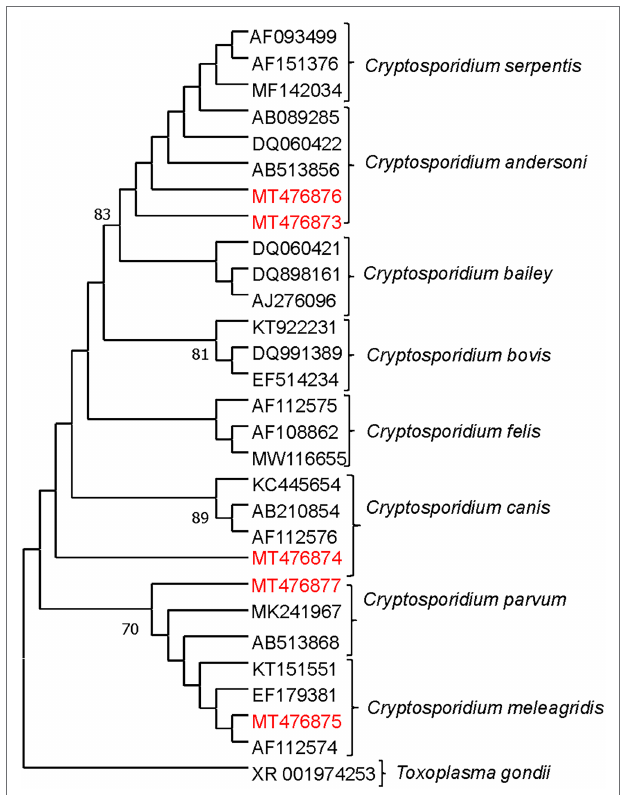
FIGURE 4 | Maximum likelihood phylogenetic analysis of Cryptosporidium detected from river water samples. The analysis was constructed by using Tamura 3 parameter model with MEGA 7.0 and the bootstrap values were calculated with 1,000 replicates. The analysis was based on the SSU gene. The phylogenetic tree was rooted to Toxoplasma gondii . The numbers at branch nodes represent bootstrap values greater than 70. Reference sequences included in the analysis are shown with their respective GenBank accession numbers. Cryptosporidium strains characterized in this study are shown in red text. Based on the Cryptosporidium species determined by the different clades of the phylogenetic tree, the possible host source of fecal contamination could be inferred. *Indicates that the sequence was inferred (or confirmed) using blast on the NCBI